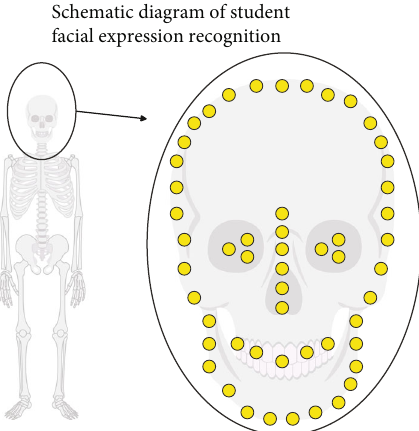
Figure 6: An example of student weariness emotion recognition in English classroom based on Internet of Things and big data